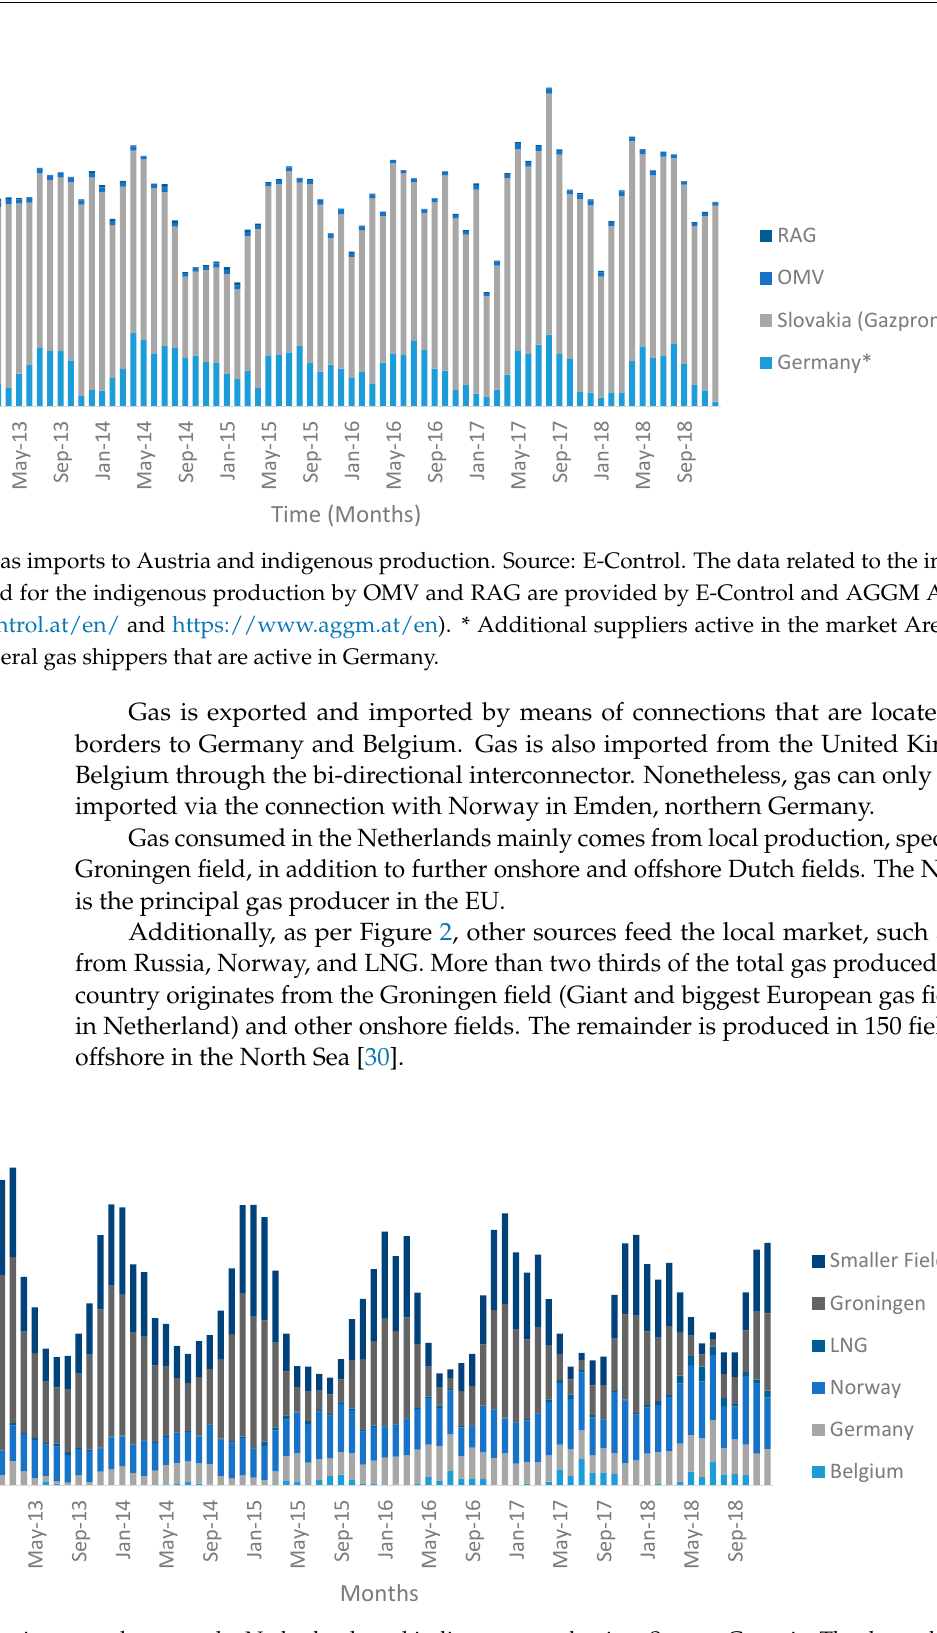
Figure 2. Monthly gas import volumes to the Netherlands and indigenous production. Source: Gasunie. The data related to the import of gas to the Dutch market can be found on the Gasunie website